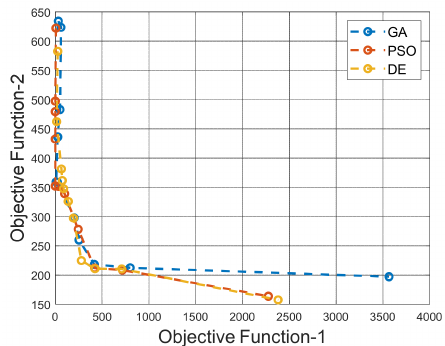
Figure 6. Relationship between number values of two objective functions. The PSO method using w 1 = 0.6 and w 2 = 0.4 as the weighting factors gives the best results. The change in the design variables, which yields these results is shown in Table 3. Table 3. The change in design